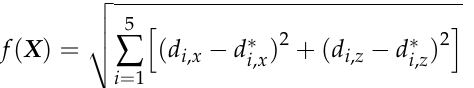
Figure 10. Layout of monitoring points.